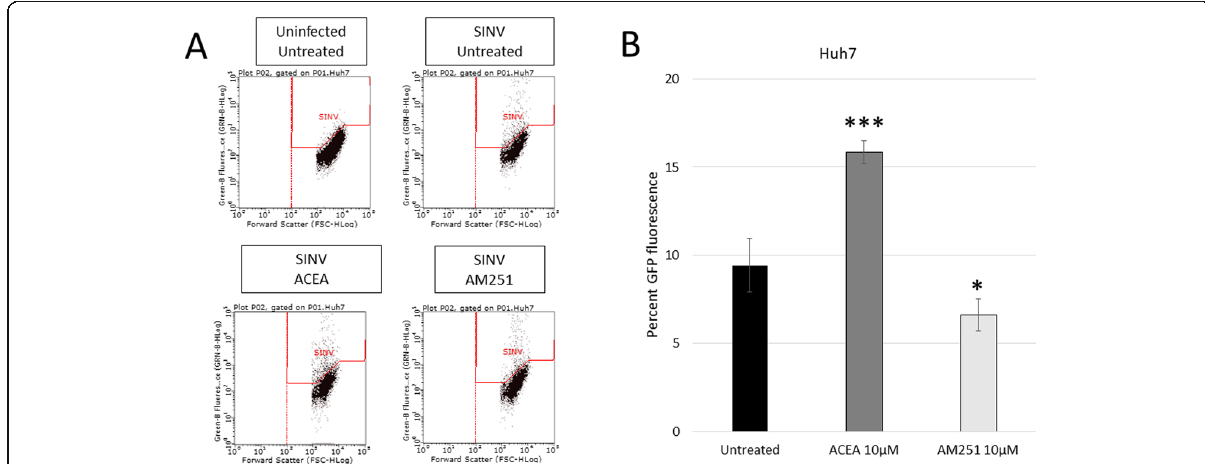
Fig. 3 Effect of ACEA/AM251 treatment on SINV-infected Huh7 cells. ( a ) Flow cytometry data of uninfected and Sindbis virus infected cells that are untreated, ACEA treated (10 μ M), or AM251 treated (10 μ M). Each dot represents a single cell in the assay ( b ) quantification of results from 3A. ACEA treatment increased the cells that are infected and AM251 decreased the cells that are infected